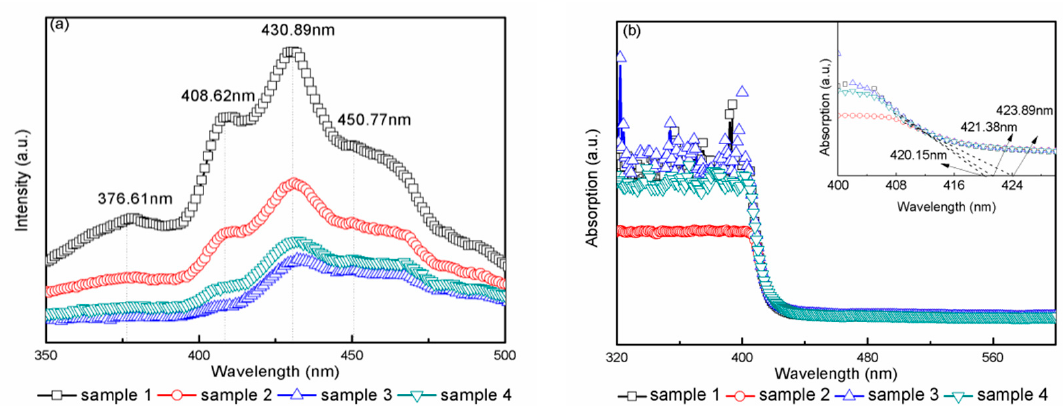
Figure 3. ( a ) Photoluminescence (PL) spectra and ( b ) absorption spectra for samples 1–4. The insert in ( b ) shows a zoomed-in view of the surrounding of the absorption